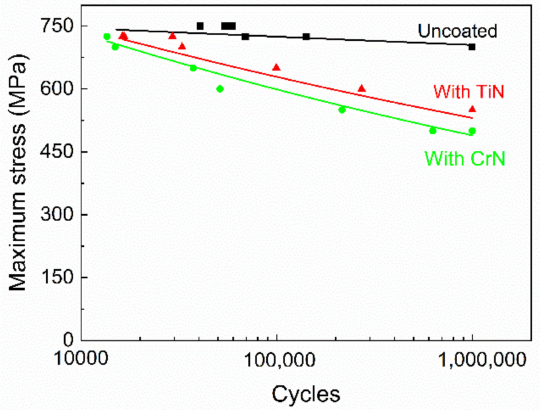
Figure 8. Rotation-bend fatigue test results of uncoated, CrN and TiN coated